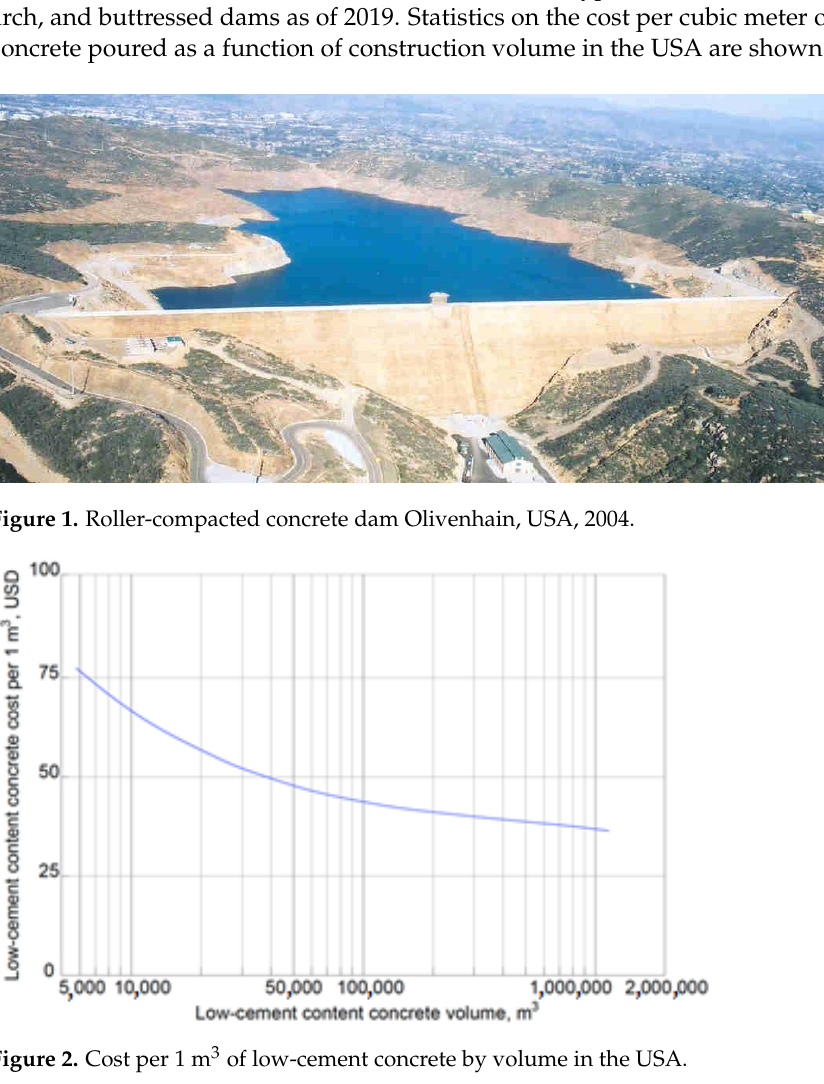
Figure 2. Cost per 1 m 3 of low - cement concrete by volume in the USA.